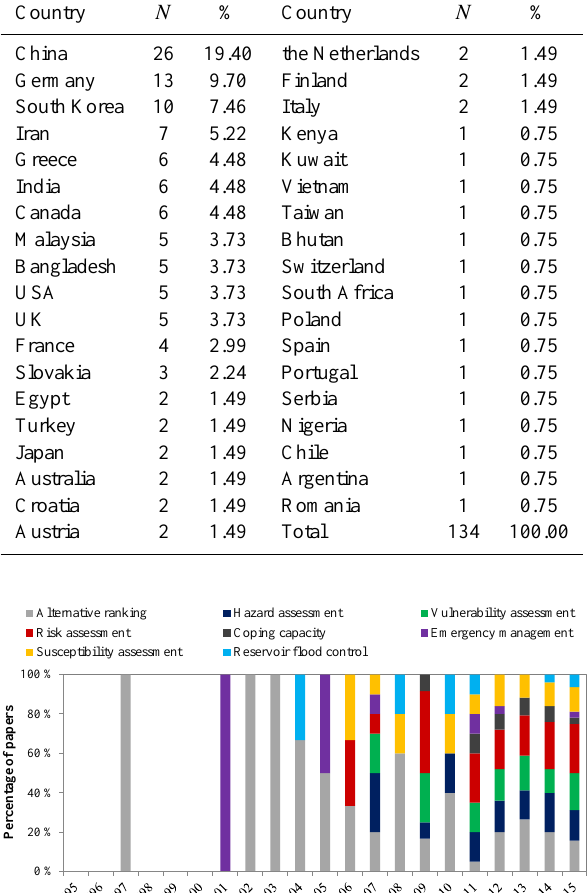
Table 2. Distribution of applications by flood risk management topic.